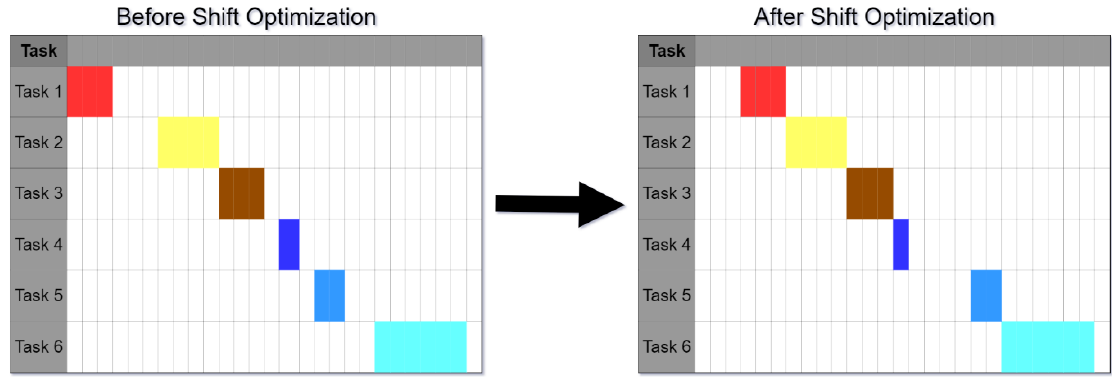
Figure 5. Example of the shift optimization for a machine work